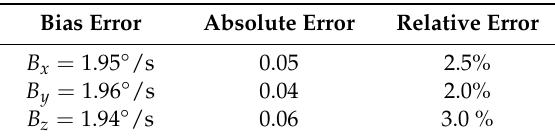
Table 8. Bias Calibration Result.